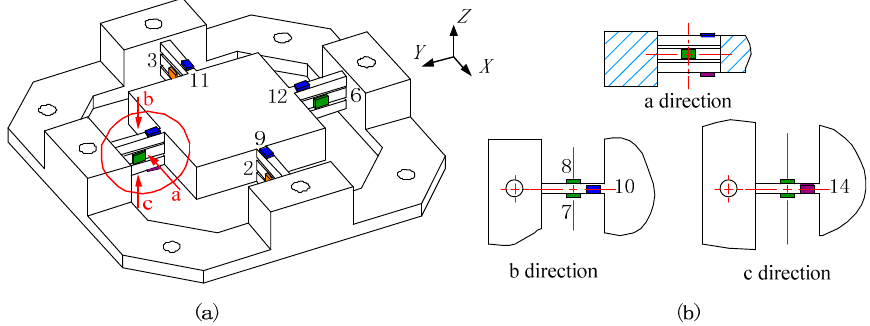
Figure 4. ( a ) Diagram of three-layer cross-beam force sensor; ( b ) partial view of sensitive area adjustment on a three-layer parallel spring element.